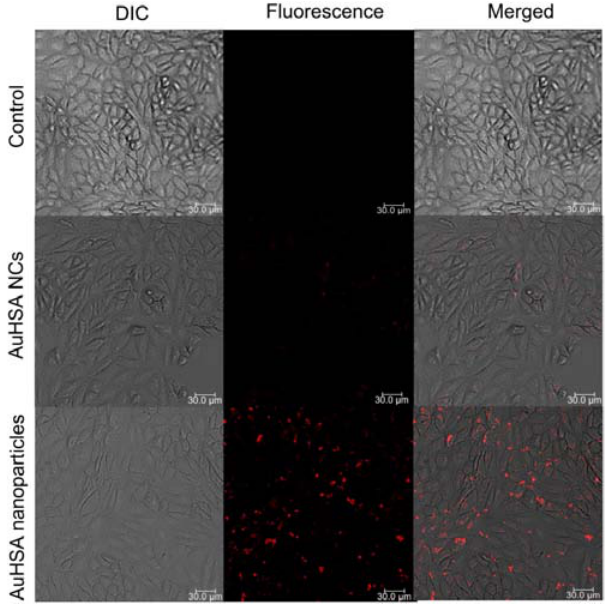
Fig. 4. Delivery of Au – HSA NCs and NC-loaded HSA nano- particles into live SPEV cells. Di®erential interference contrast (DIC), FL, and an overlay of these modes are given. Scale bars are 30 (cid:1)